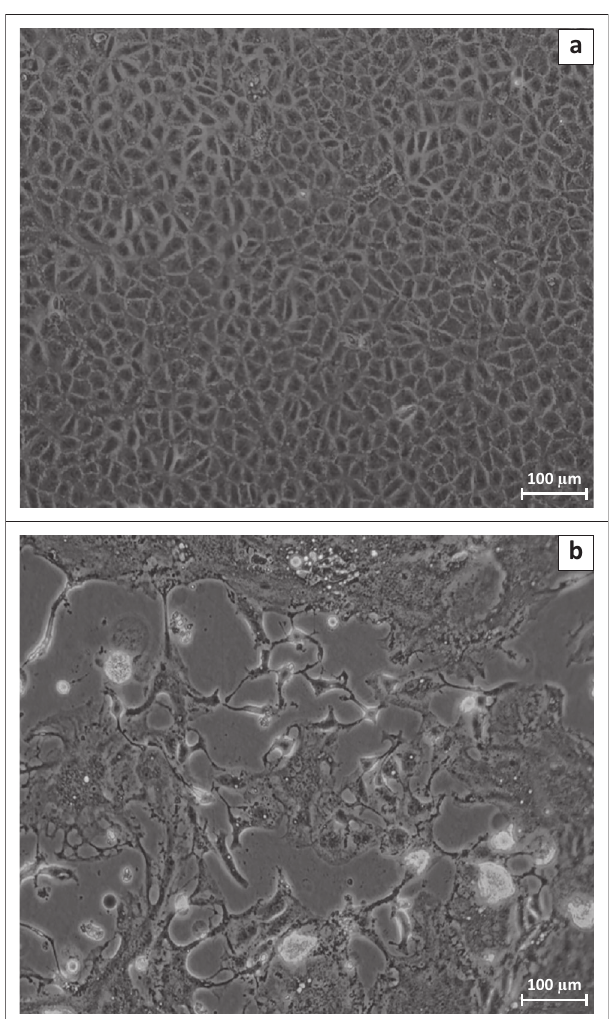
FIGURE 3: Canine histiocytic sarcoma cells at 100 % confluence observed under a light microscope, ×100 magnification, when (a) non-infected or (b) with cytopathic effect (CPE) because of Peste des petits ruminants viruses